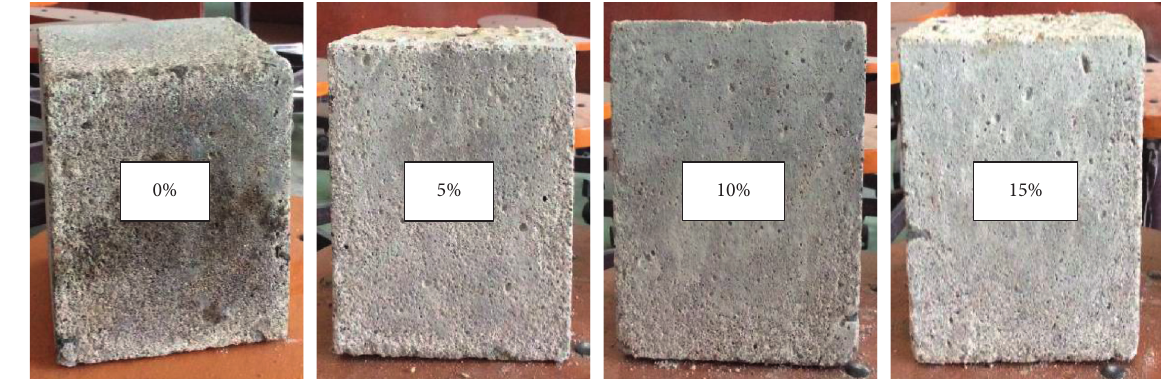
Figure 1: OPC-WPPA concrete deterioration in 2% sulfuric acid solution.